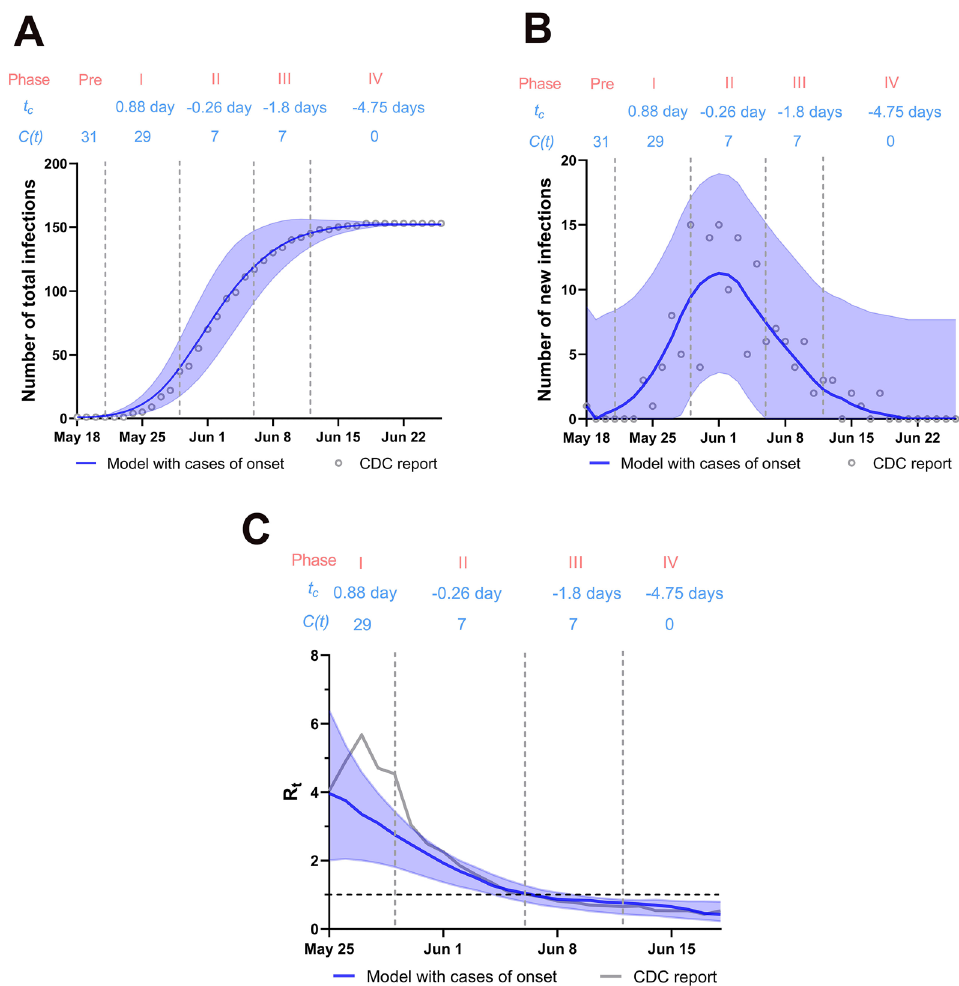
Figure 4. Cumulative infections, new confirmed cases, and R t according to the model and CDC reported data. ( A ) Cumulative infections; ( B ) new confirmed cases; ( C ) R t ; Blue shaded areas show the 95% CI for simulation with case of onset. t c : time from onset of infectiousness to quarantine/isolate; C(t) : Average contact